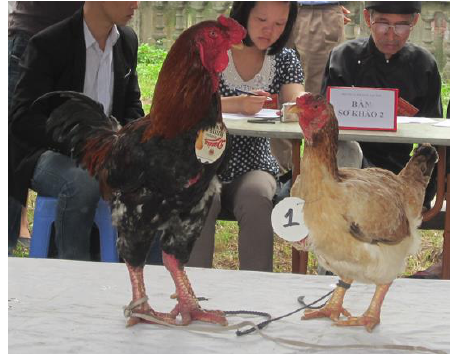
Figure 2. Adult female (left) and male (right) Dong Tao chickens.